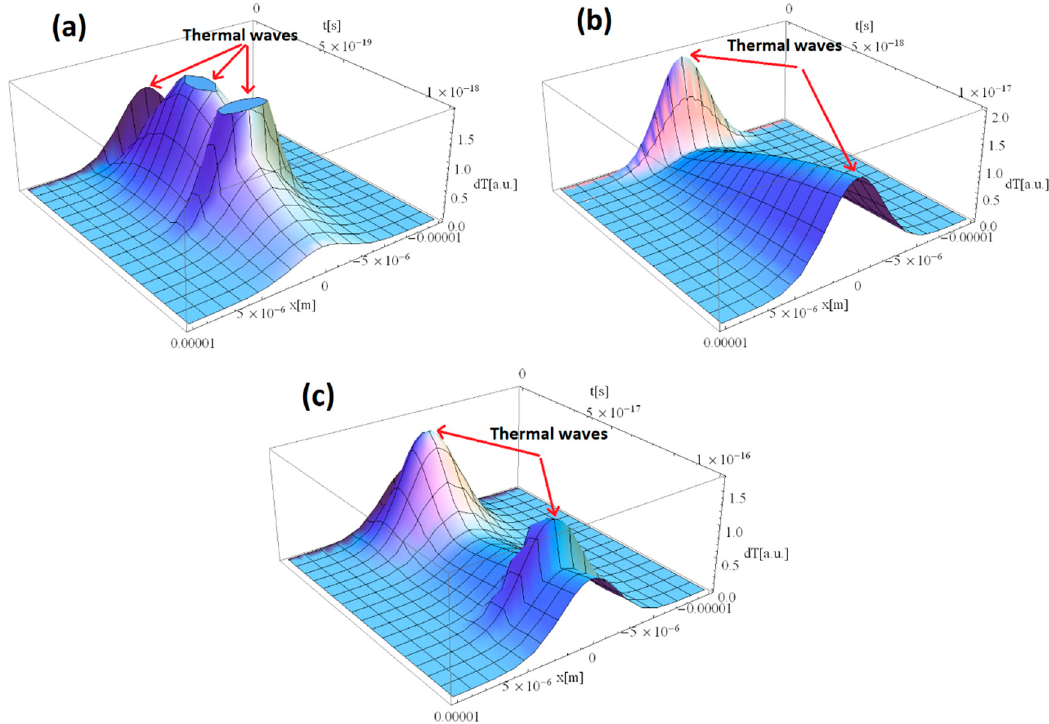
Figure 3. Laser–Al interaction for different durations of the laser pulse: ( a ) 1, ( b ) 10, and ( c ) 100 as.